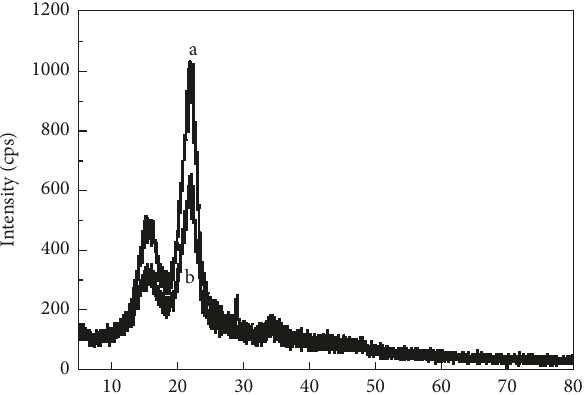
Figure 10: XRD images of modified rice stem: (a) before adsorption of uranium(VI); (b) after adsorption of uranium(VI).